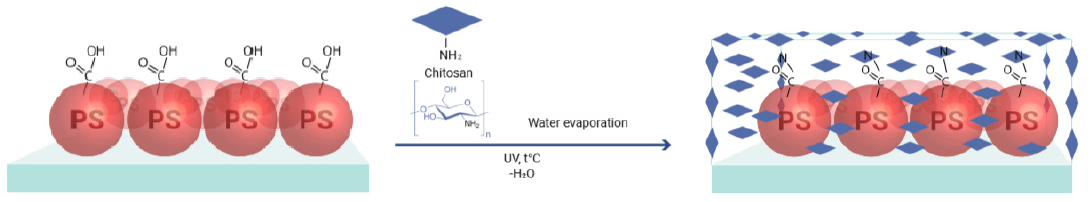
Figure 5. Schematic illustration of the crosslinking process of the PS–AA copolymer with chitosan.